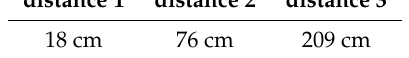
Table 1. Distance between the transmitting and receiving electrodes in Figure 2.